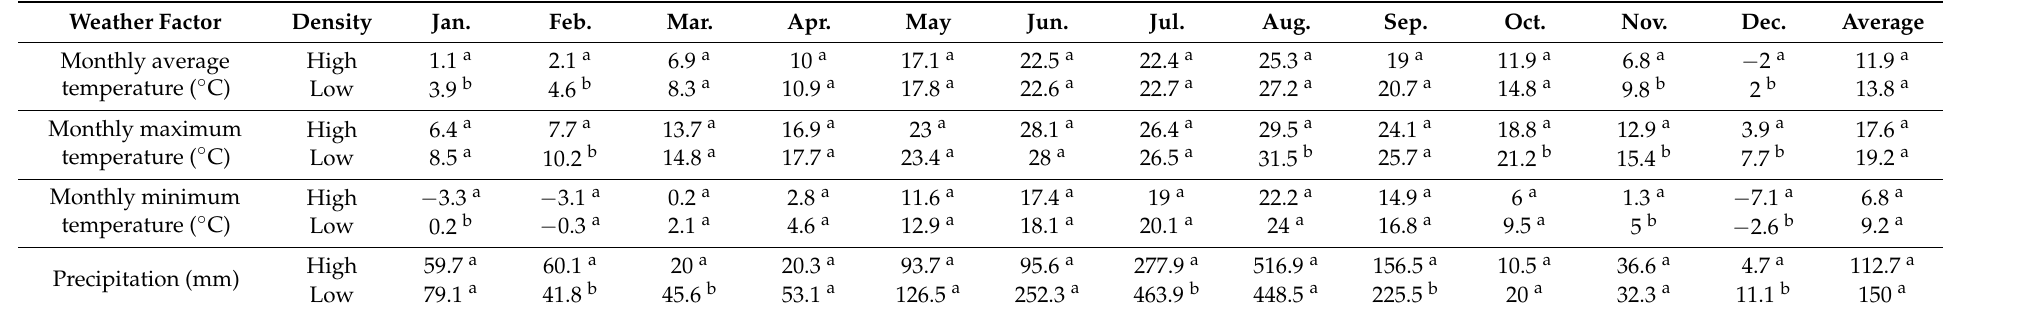
Table 1. Spatial analysis of weather data in areas with high and low spongy moth density in 2020.